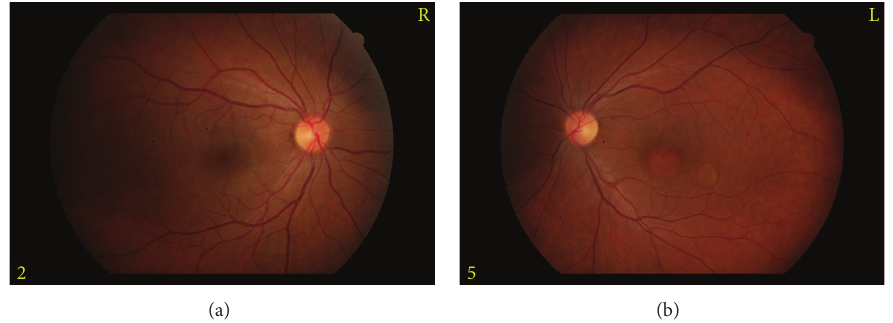
Figure 1: A small vesicle under the superior temporal quadrant of the right eye (a) and two separate vesicles filled with liquid in the left eye (b).